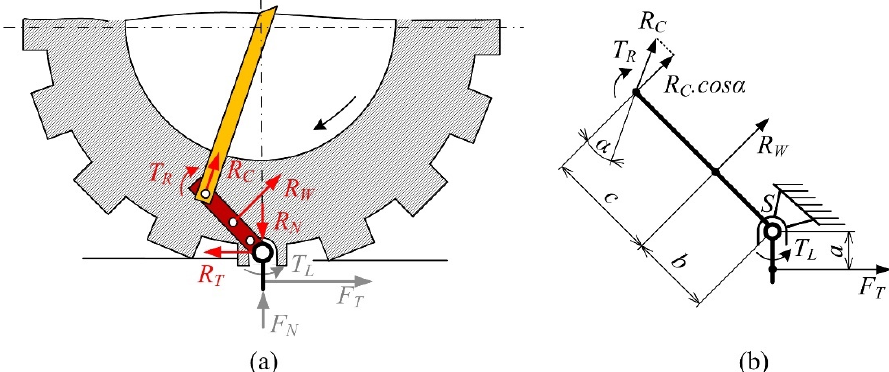
Figure 4. Forces and reactions acting on the spike segment: ( a ) spike segment with tire, ( b ) details: F T —tangential force acting on the spike, F N —normal force from soil penetration, R T and R N —tangential and normal reactions in tire tread pattern from the spike segment, R W —reaction in the control wire strand, R C —reaction in the rod of the control mechanism, T L —load moment, T R —reaction moment, S—support, and α —inclination angle of control lever, a , b , and c —the force arms